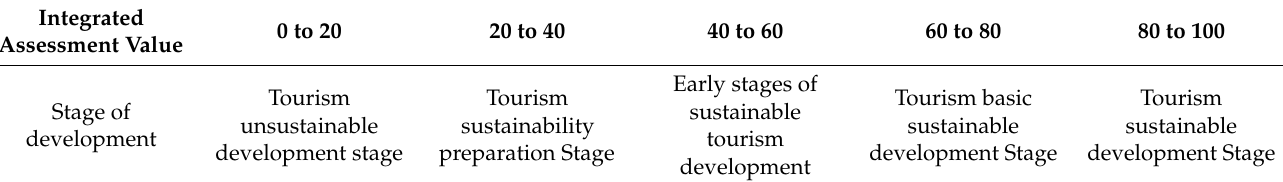
Table 5. Stages of Sustainable Tourism Development.